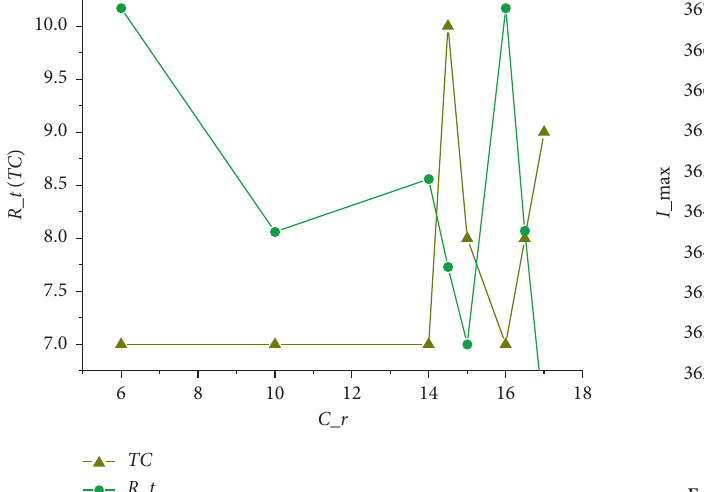
Figure 13: Diagram of rework cost-maximum revenue.